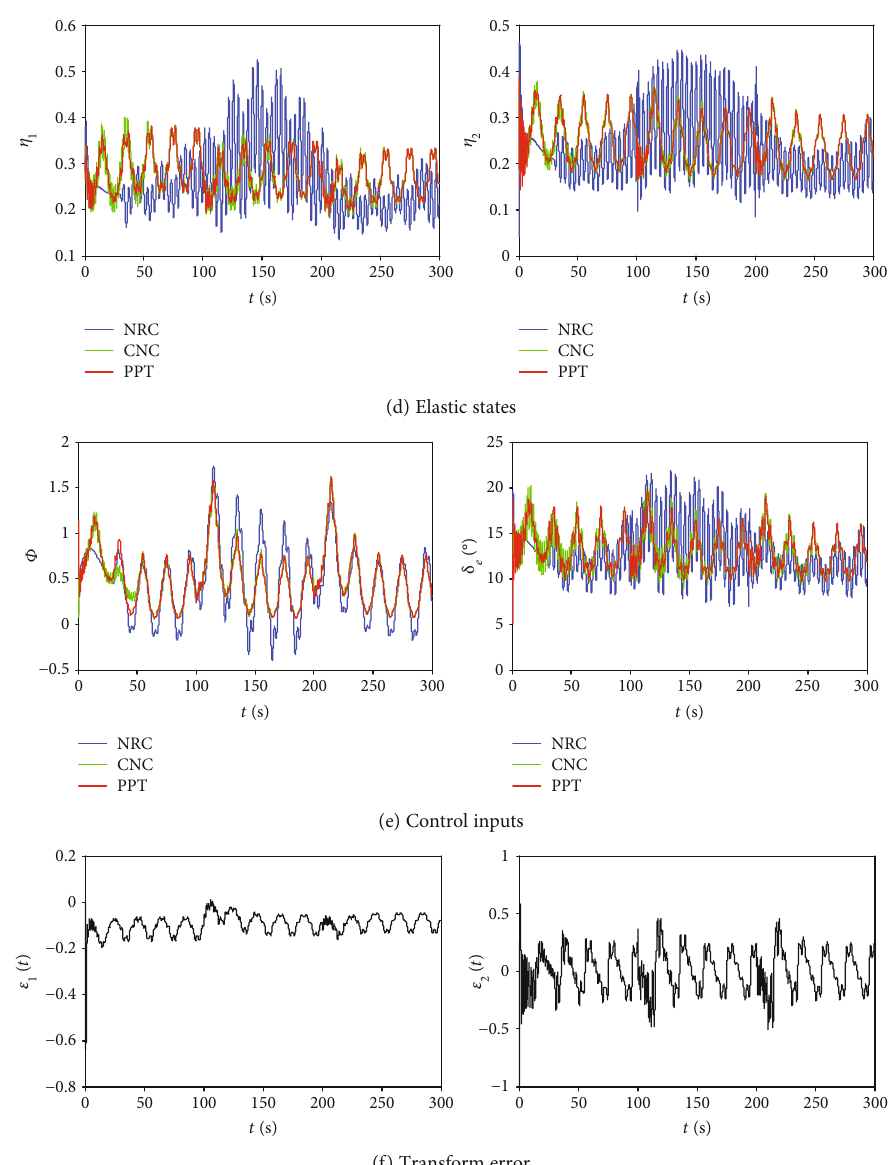
Figure 3: Case 2 simulation